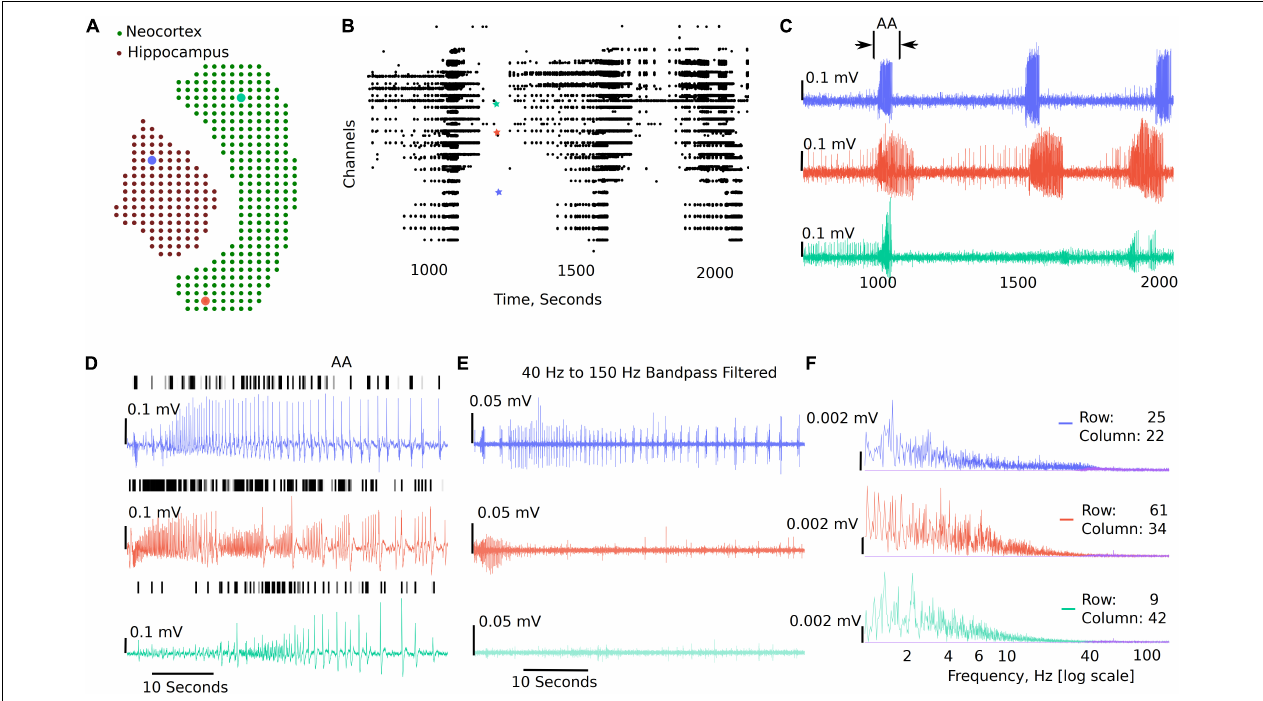
FIGURE 3 | Example visualizations generated from the GUI including raster plots, time-series traces, LFP activity peaks, and time frequency transformations. (A) 407 channels selected for this analysis representing the MEA sensor spatial array, covering both the neocortex and the hippocampal regions. (B) Raster plot for all the channels in the working file irrespective of brain regions for a selected time range, demonstrating time points of when the activity occurs in the slice. (C) Three selected traces: the blue trace from the hippocampal region, the red trace from one end of the neocortex, and the aqua trace from the other end of the neocortex. (D) Zoomed in view of the first seizure [the region bracketed in panel (C) as AA], with the black dashes showing a peak find function within the GUI. (E) This demonstrates the ability to plot filtered traces along with the raw traces. (F) The amplitude frequency transformations for the traces in panels (D,E) (band-pass filtered). The filtered FFT spectrum for each is shown in purple.